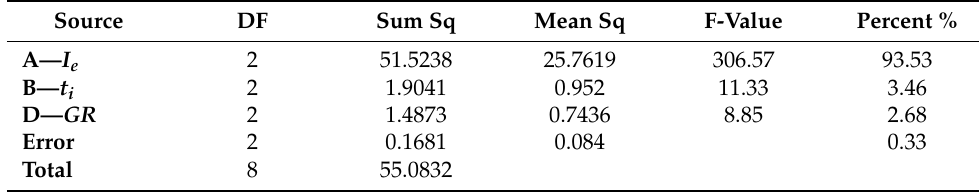
Table 6. Reduced ANOVA table based on the Taguchi plan.